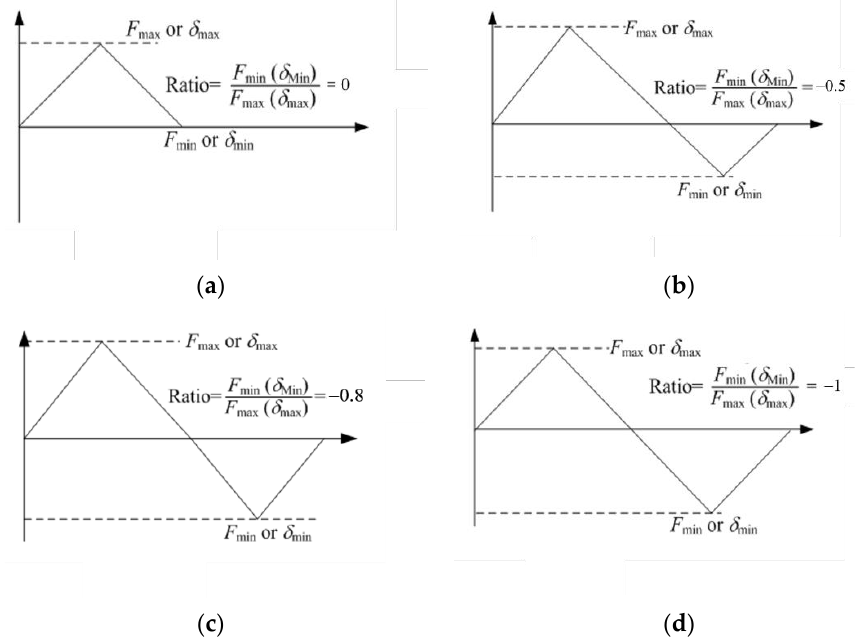
Figure 5. Loading waveforms under different ratios. ( a ) Ratio = 0; ( b ) Ratio = − 0.5; ( c ) Ratio = − 0.8; ( d ) Ratio = − 1.